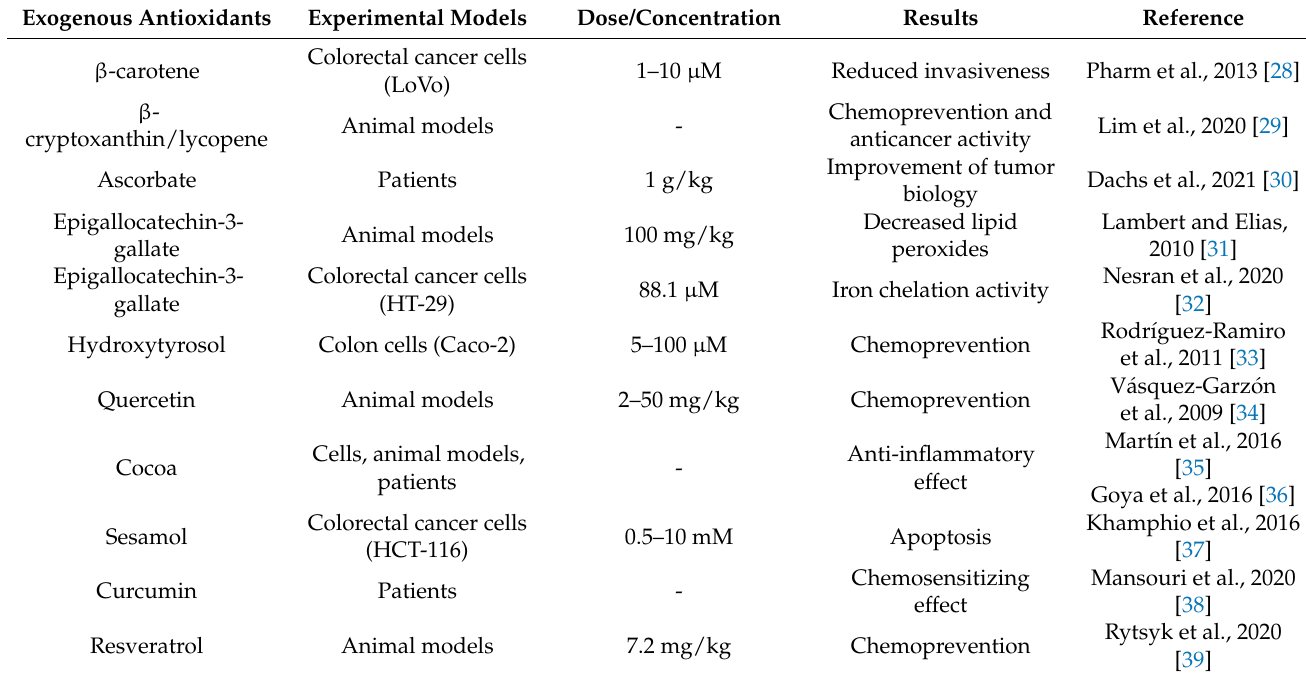
Table 1. Summary table of the main exogenous